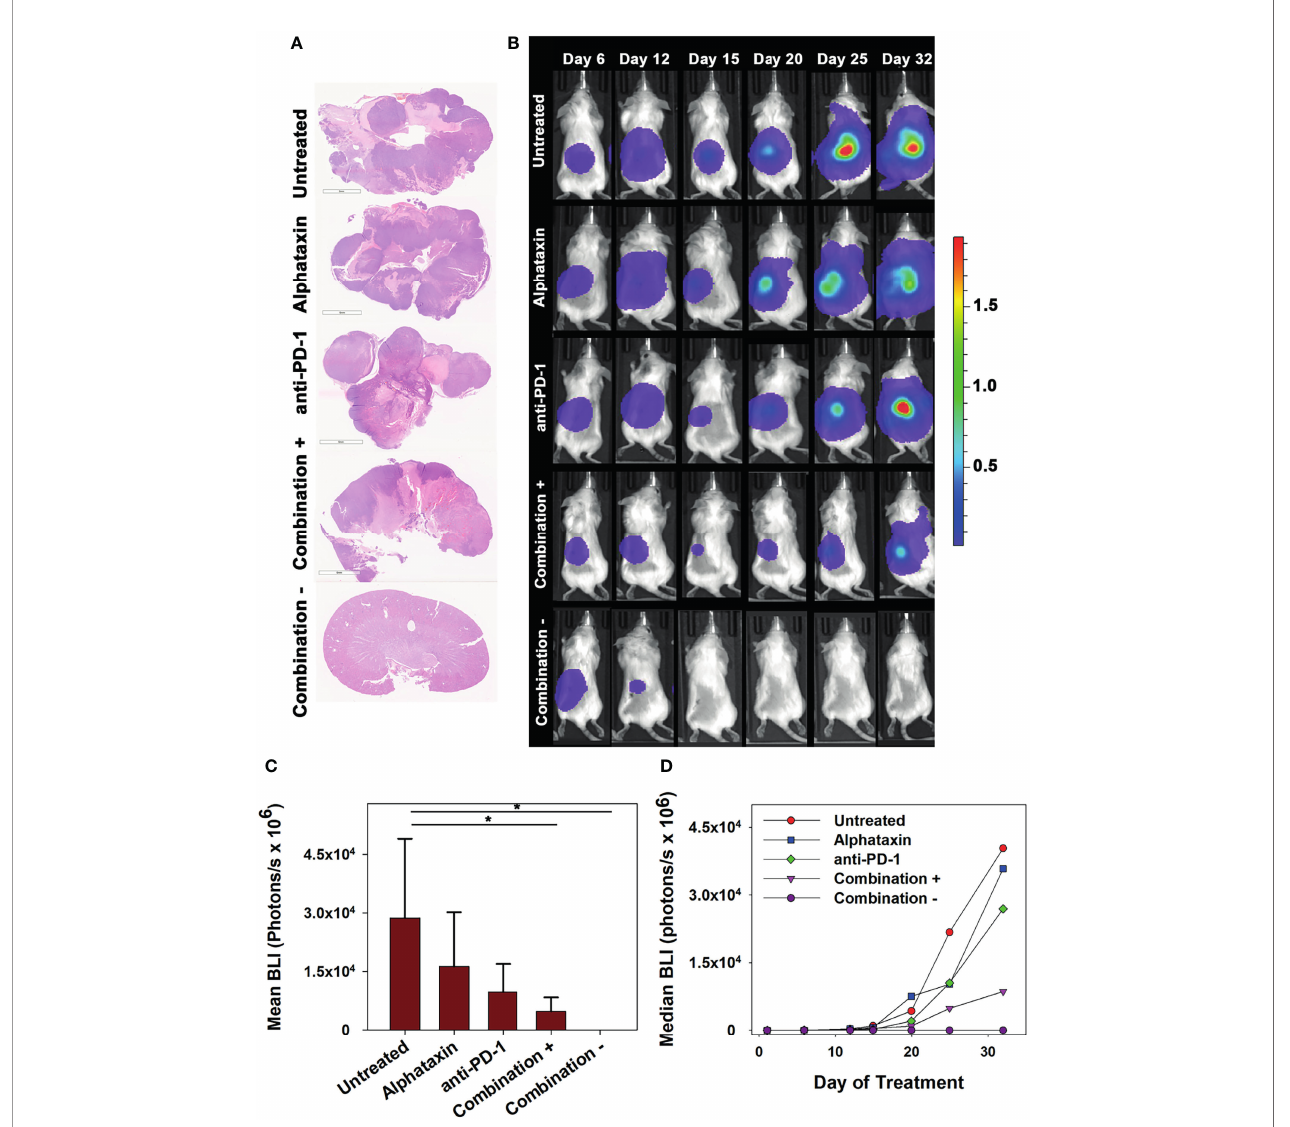
FIGURE 6 | Long-term Remission Achieved by Treatment with Alphataxin and an Anti-PD-1 Antibody. Mice were orthotopically implanted with 5x 10 3 Renca-GL cells, and treatment was initiated the following day. (A) Kidneys were excised at the time of euthanization and stained with H&E. Images were captured at identical magni fi cation, and representative images at 1X are shown. (B) Longitudinal dorsal images of the orthotopic kidney tumor growth of mice. A representative animal that showed similar bioluminescence with at least 2 other animals within the same treatment arm after 25 days of treatment was selected from each treatment arm. The mice in the combination treatment arm were bifurcated into 2 groups, those with tumors ( “ Combination + ” , 4 th row, n = 4) and those without tumors ( “ Combination − ” , 5 th row, n = 2). The luminescence color scale represents photons/sec/cm 2 /steradian x 10 9 with minimum 4.48e6 and maximum 19.4e9. (C) As compared with untreated mice and monotherapy, after 25 days of treatment the tumor volumes (BLI) were signi fi cantly smaller in mice receiving combination treatment with tumors ( P = 0.05, n = 4)and without tumors( P = 0.02, n = 2).After 25 daysoftreatment, there were nosigni fi cant differences between untreated andAlphataxin-treated mice ( P = 0.24, n = 6/arm) orbetween untreated andanti-PD-1-treated mice ( P = 0.06, n = 6) although the difference between untreatedand anti- PD-1-treated mice have practical statisticalimportance. Meansand standard deviationsare depicted. (D) Median longitudinal tumor growth demonstrates that as compared with untreatedanimals ( ),Alphataxin ( ) and anti-PD-1( ) individually impeded tumor growth and incombination + animals ( ),substantially impeded tumor growth while incombination – animals( ), tumor growth regressed.Asterisksdesignate statistically signi fi cant differences (*P <